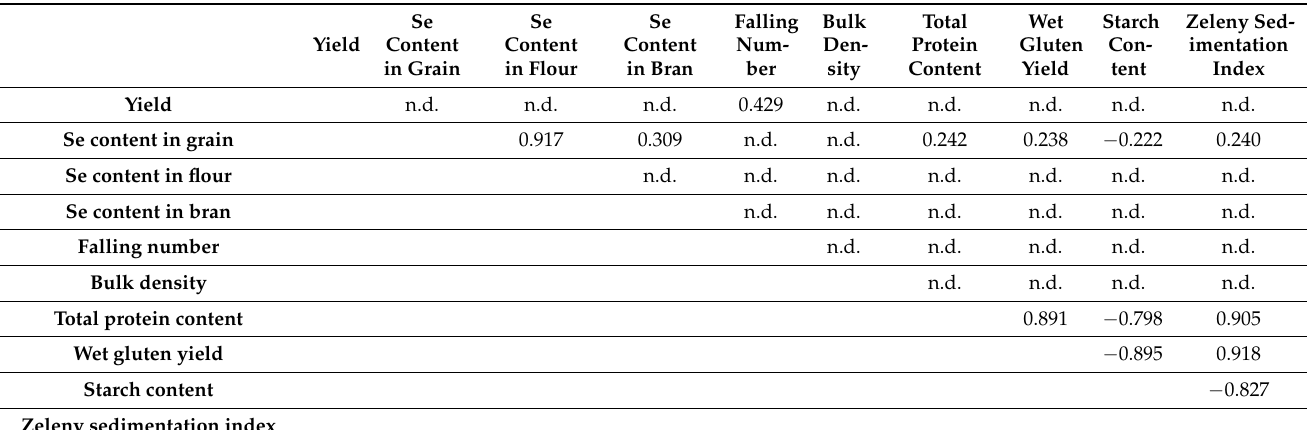
Table 3. Pearson linear correlation